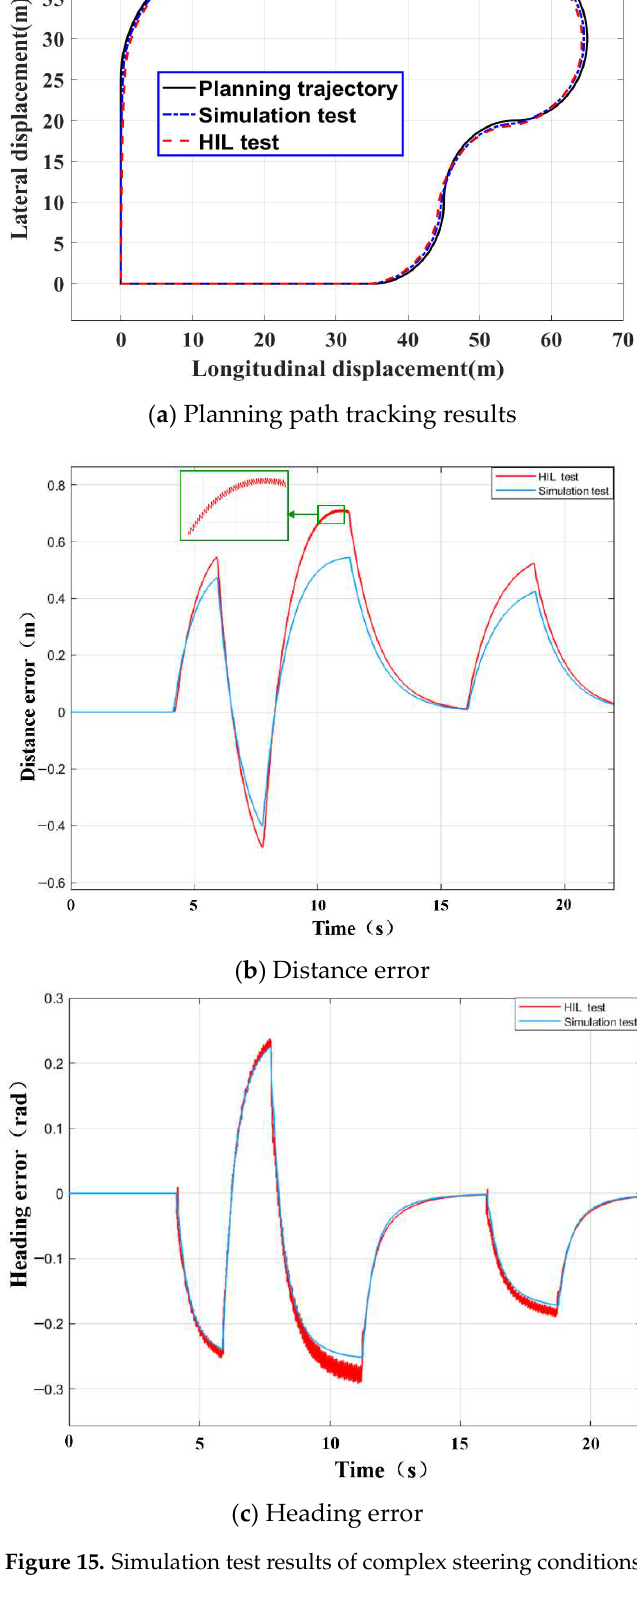
Figure 15. Simulation test results of complex steering conditions